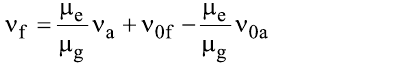
slope 1.529, indicating a substantial (53%) increase of the dipole moment upon excitation of NR. A clear deviation is ob- served for protic solvents and highly polarizable solvents (with n = 1.421 − 1.494) due to the different efficiency of hydrogen bond formation and contributions of inductive solute–solvent interactions in the ground and excited